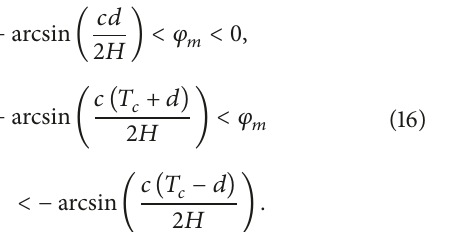
Here 𝐹 𝑙 (𝑟) = max 𝜃 { arg 𝜑 𝐹 (𝑟) = min 𝑢